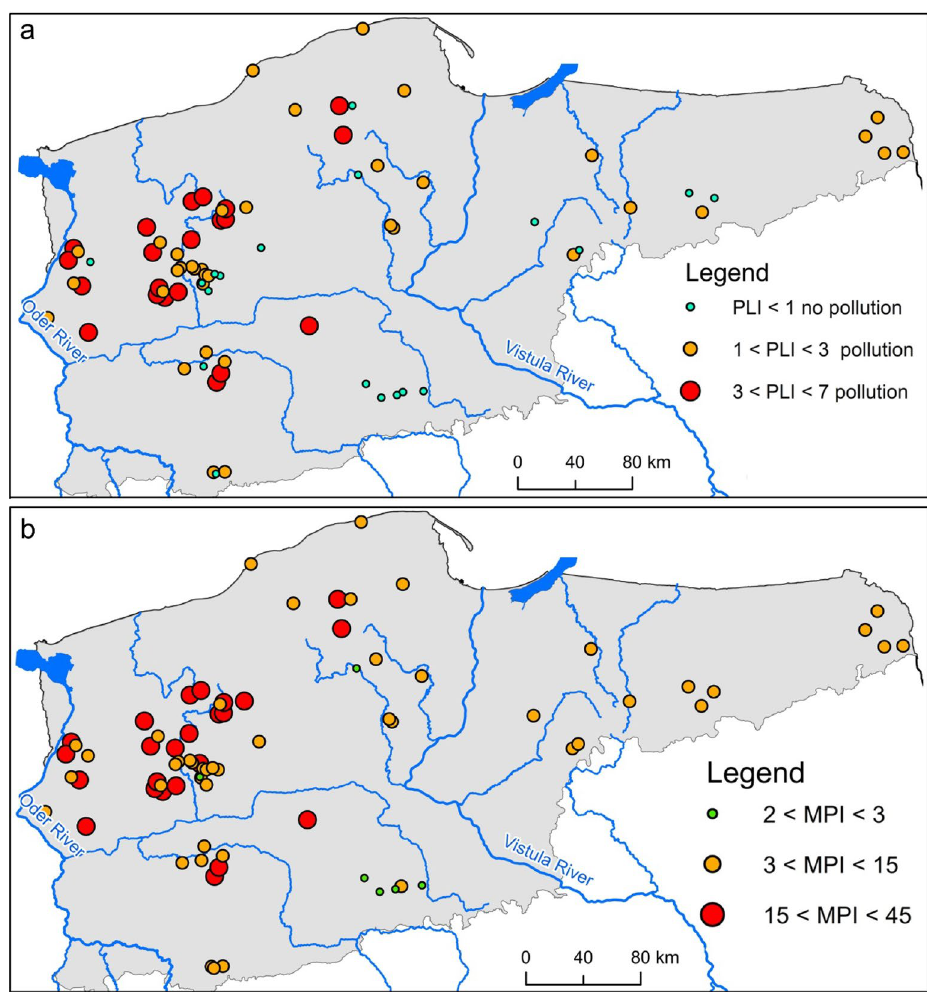
Figure 5. State of HM pollution of lake surface sediments based on PLI ( a ) and MPI ( b ) (the figure was generated in ArcMap 10.7, https:// deskt op. arcgis. com/ en/ arcmap/).